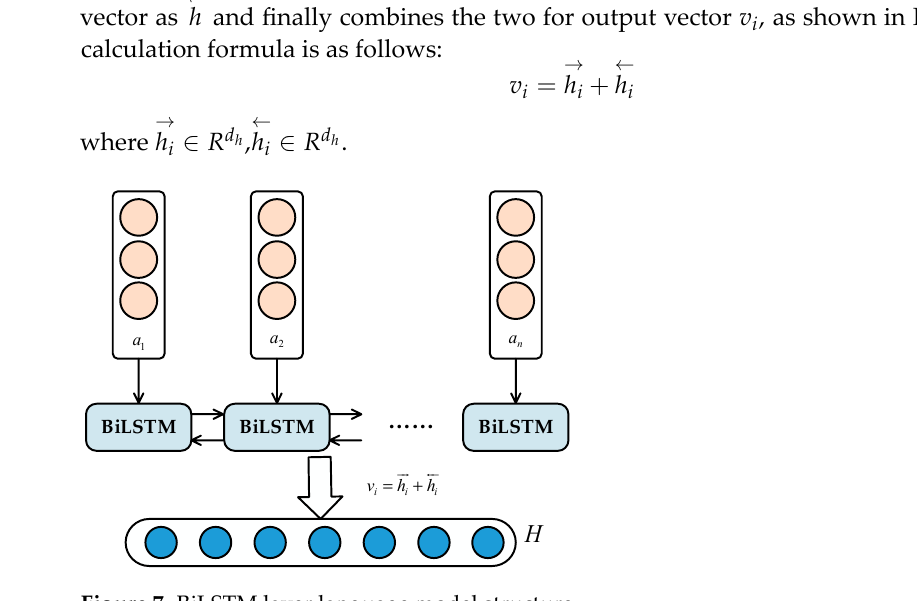
Figure 7. BiLSTM layer language model structure.